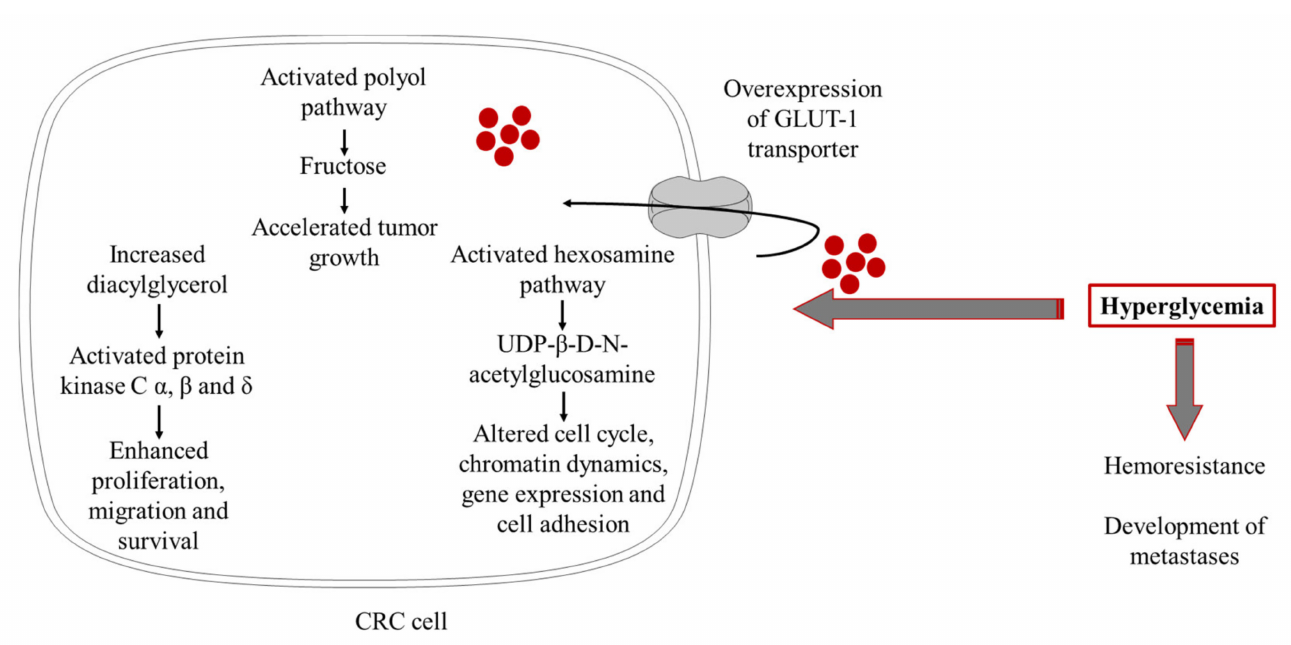
Figure 2. The role of hyperglycemia in pathogenesis of CRC (The figure was composed using Servier Medical Art templates, licensed under a Creative Common Attribution 3.0 https://smart.servier.com (accessed on 12 November